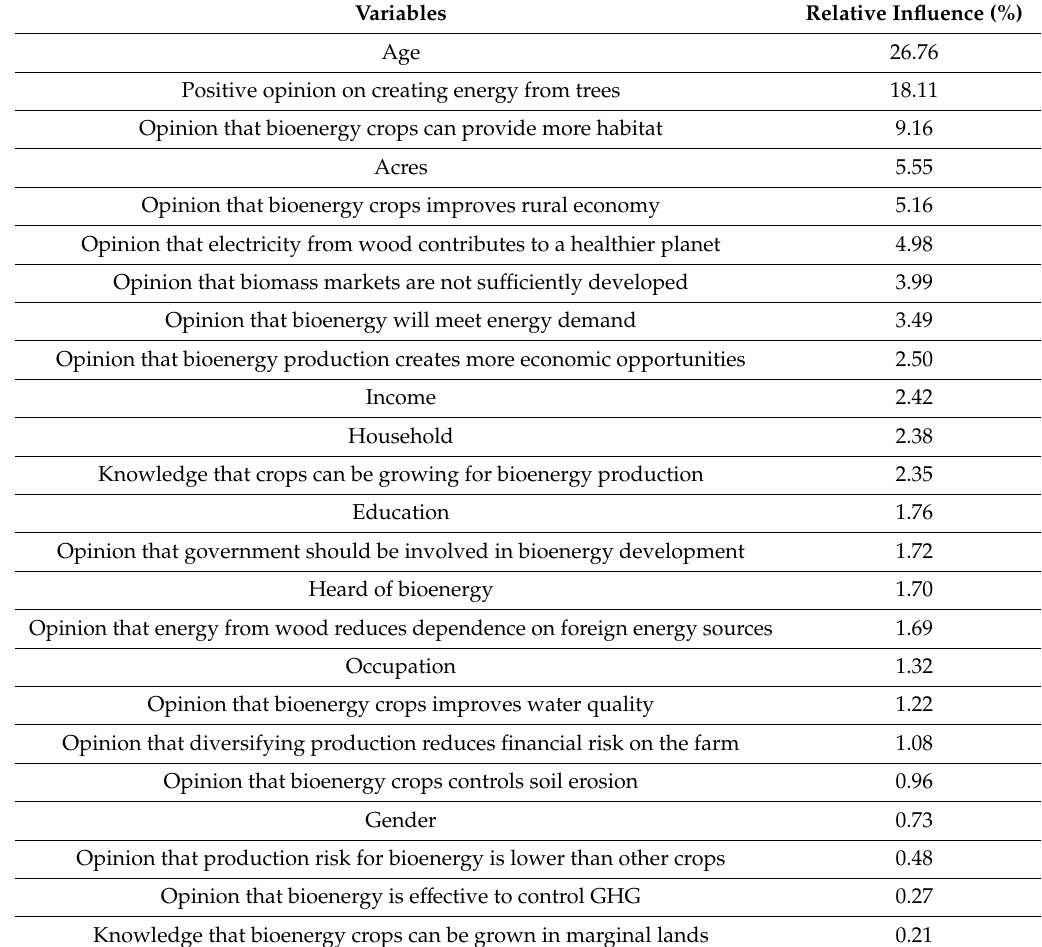
Table 5. Variables and their relative influence on landowners’ willingness to produce /